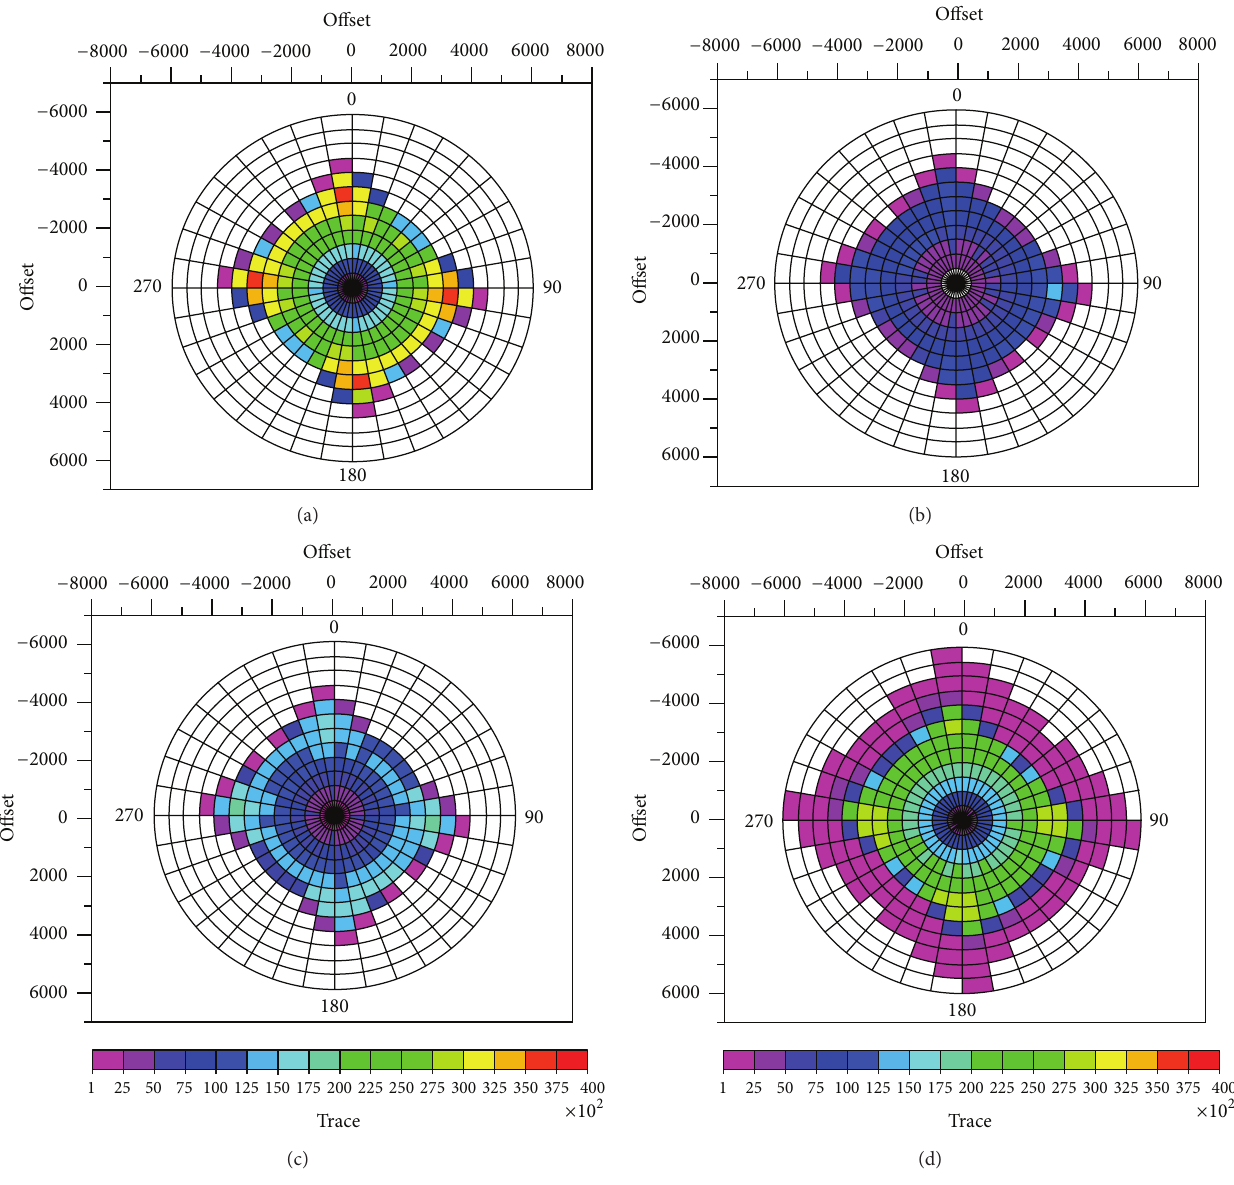
Figure 6: Total ray coverage at target levels in (a) acquisition with no cultural noise, (b) acquisition with real cultural noise, (c) traditional recovery method applied on (b), and (d) new recovery strategies applied on (c).